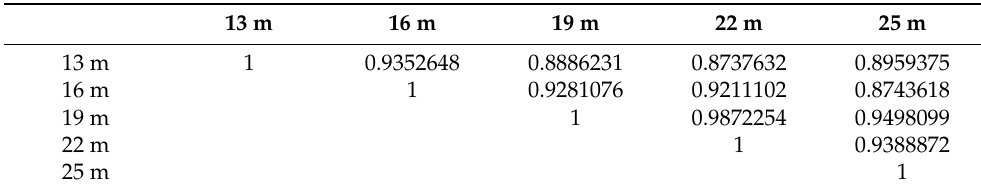
Table 2. Correlation